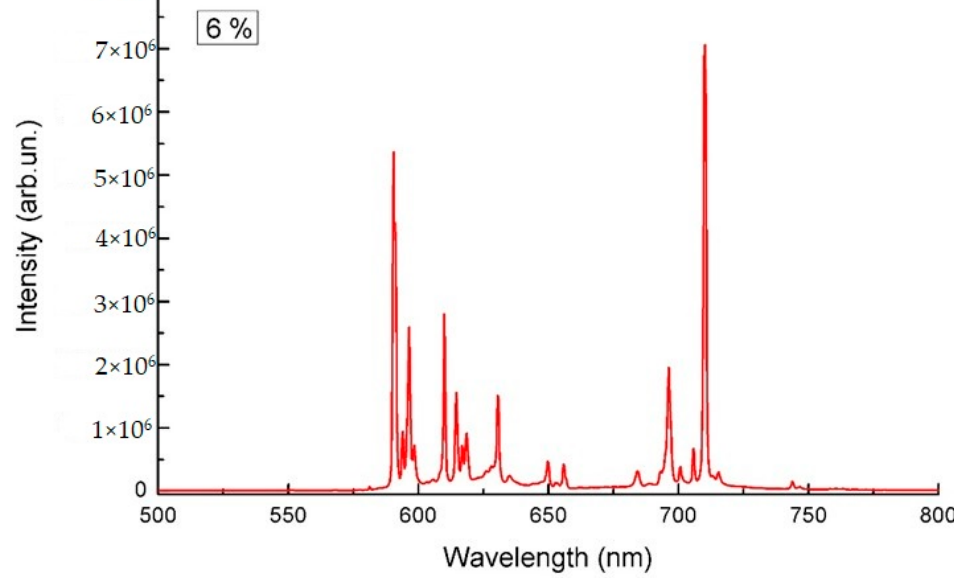
Figure 11. The photoluminescence spectra of YAG:Eu (6%). Eu 3+ has emissions in the red 5 D 0 → 7 F 1 (625 nm) and orange 5 D 0 → 7 F 1 (580 nm) ranges; this is used in different inorganic compounds targeting white light emission [6]. In the case of 2% Eu, we can observe that the lines at 579 and 626 nm corresponded to